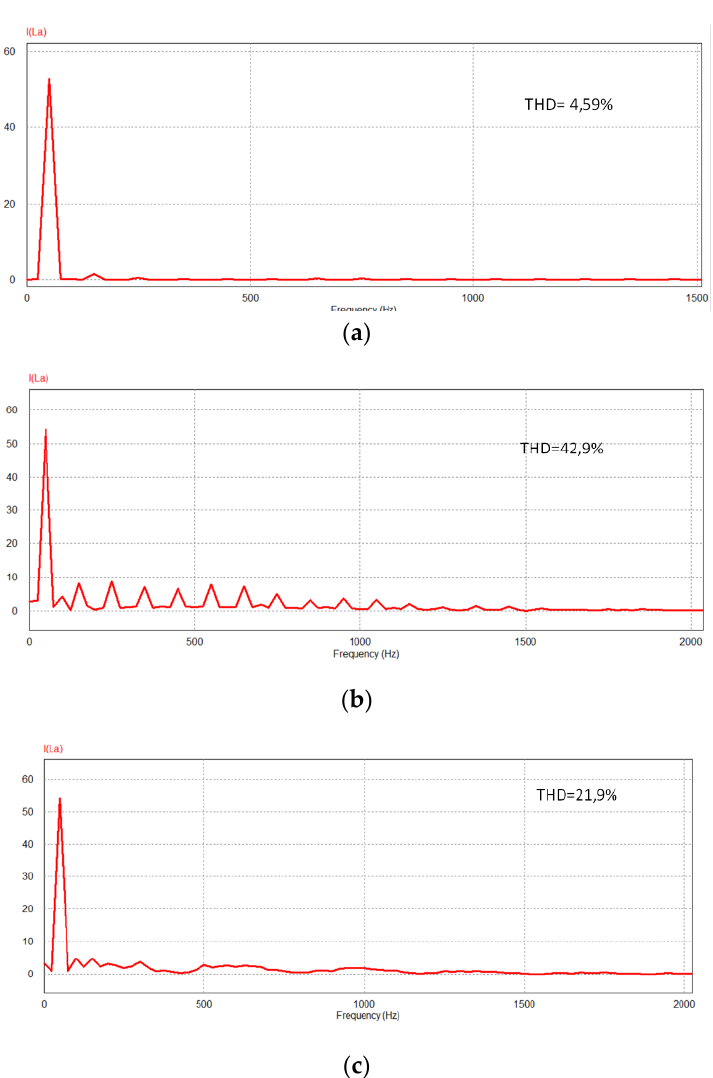
Figure 14. FFT analysis for input current I La : ( a ) healthy condition, ( b ) ON-fault T 2 , ( c ) diagnosis + tolerant method.